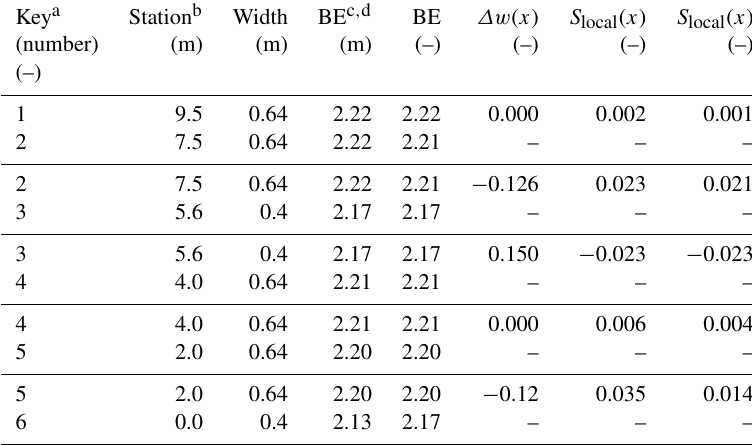
Table B5. Measurement details for Fig. 5 of Vahidi et al.